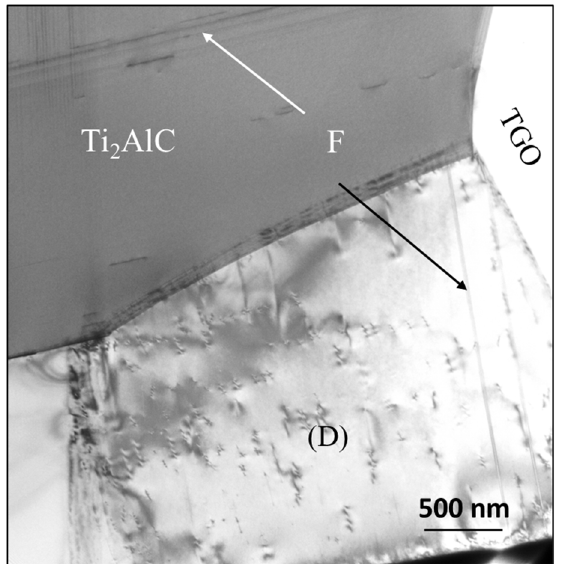
Figure 14. Ti 2 AlC grains with planar faults (F) and irregular dislocations (D).